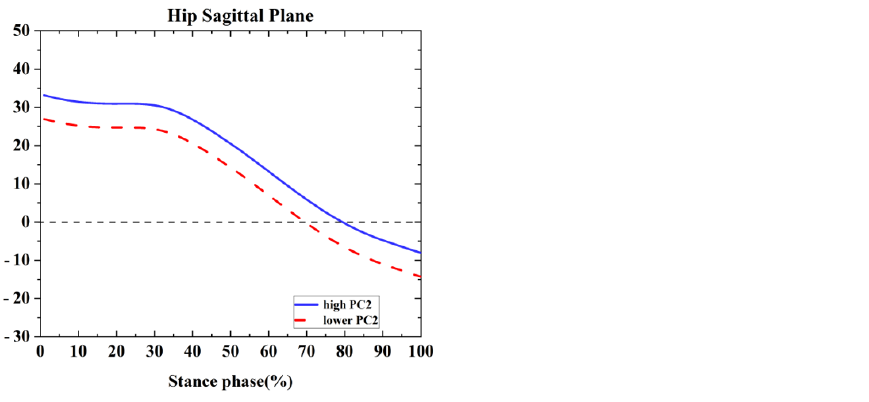
Figure 8. Principal components are retained for the hip. The waveform differences between competitive runners and recreational runners of reconstruction principal using the high and lower PC2-scores in the sagittal plane.